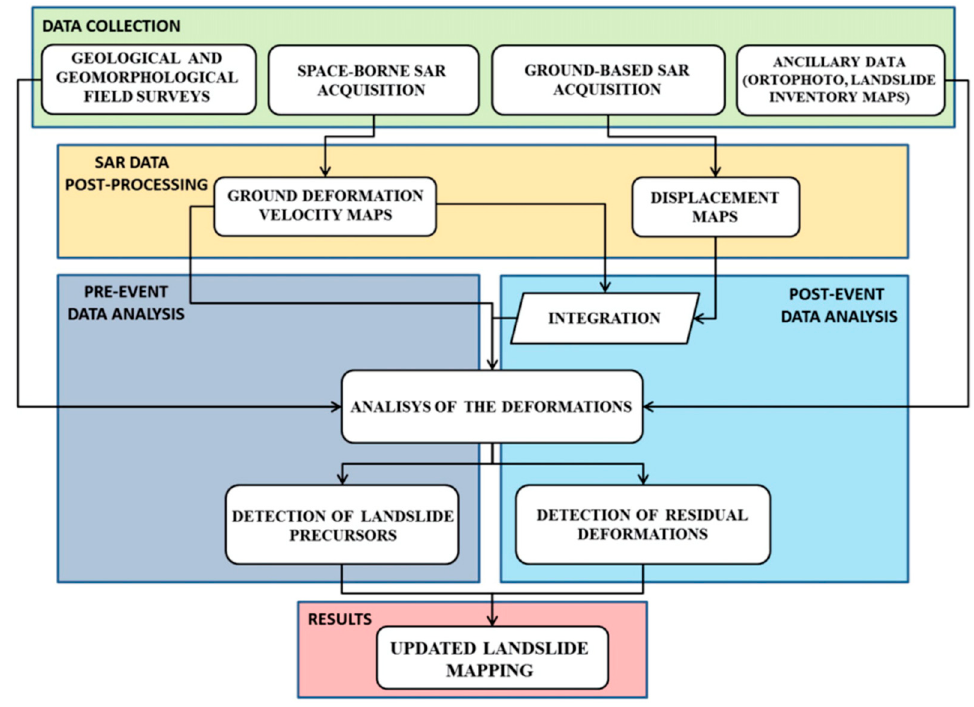
Figure 9. Data flow-chart that integrates geological and geomorphological field survey, space-born SAR acquisitions, orthophotos, and inventory map (after